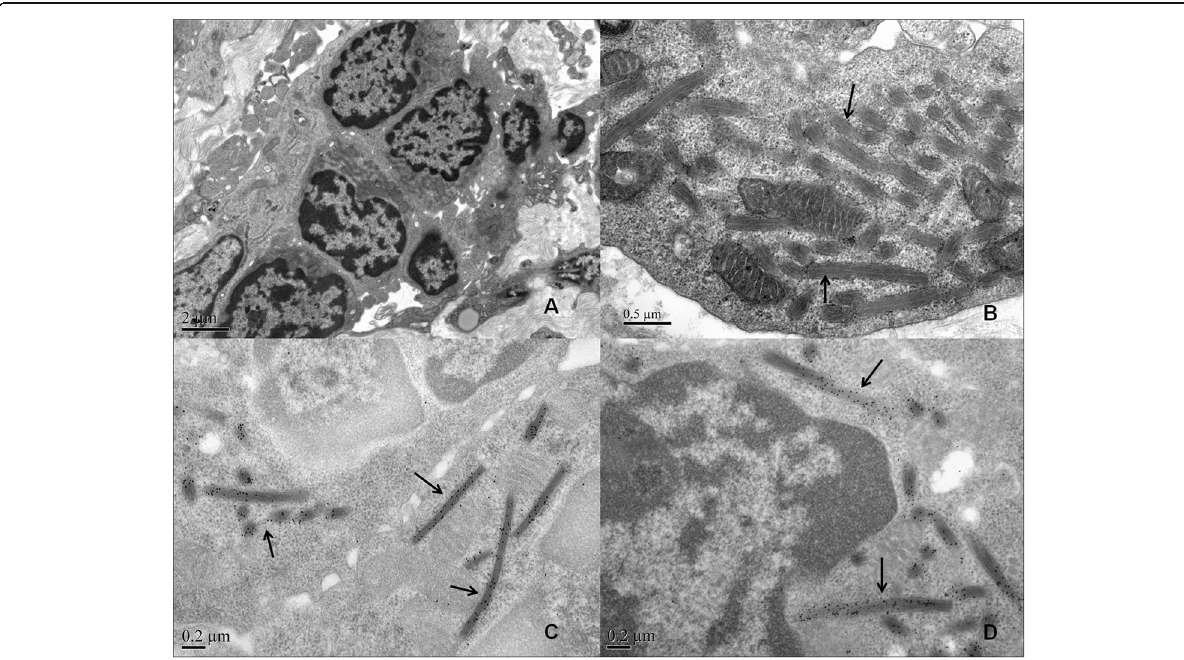
Fig. 2 Representative electron microscopy findings of renal biopsy in case 6. A . Neoplastic cells infiltration was seen in the renal interstitium (×10,000). B . Special cytoplasmic crystals characterized by fuzzy filament structure were found in infiltrating neoplastic cells as indicated by arrows (×40,000). C . Intense IgG1 was detected in the crystalline structures of neoplastic cells as indicated by the arrow (Immunoelectron microscopy, ×50,000). D . Intense kappa was detected in the crystalline structures of neoplastic cells as indicated by the arrow (Immunoelectron microscopy, ×50,000)